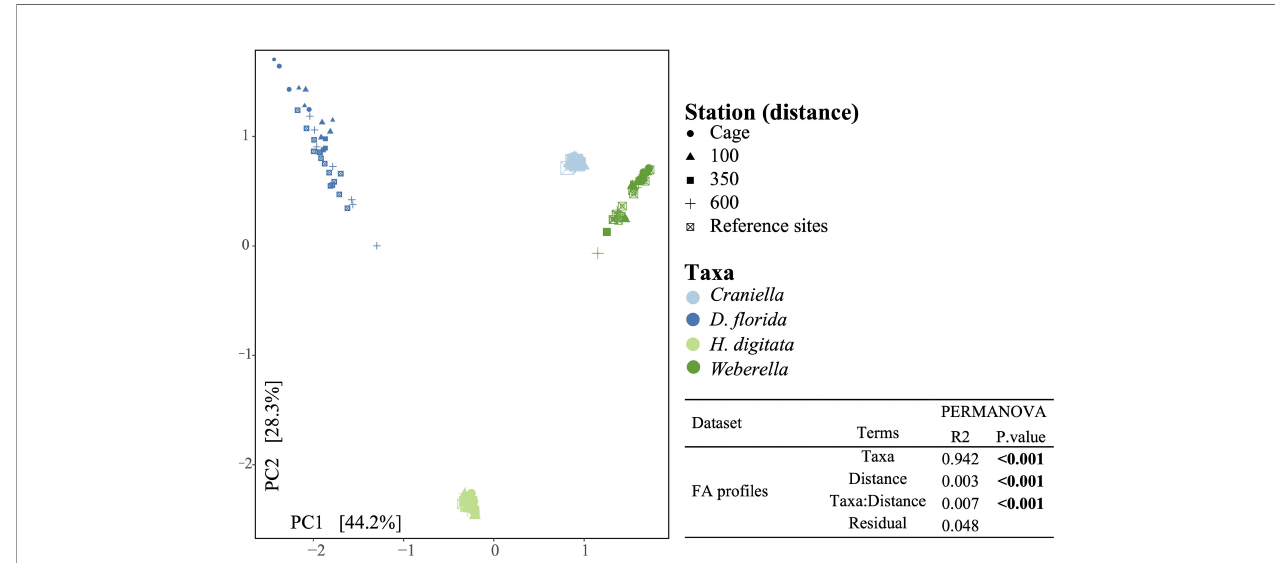
FIGURE 10 | Principal component analysis of the fatty acid pro fi les colored by epibenthic taxa and shaped according to distance from the fi sh farm. Result of a permutational analysis of variance (PERMANOVA; 9,999 permutations) testing the difference between taxa and the effect of 4 th root of distance from farm is displayed at the lower right corner, with signi fi cant relationship (p.value <= 0.05) highlighted in